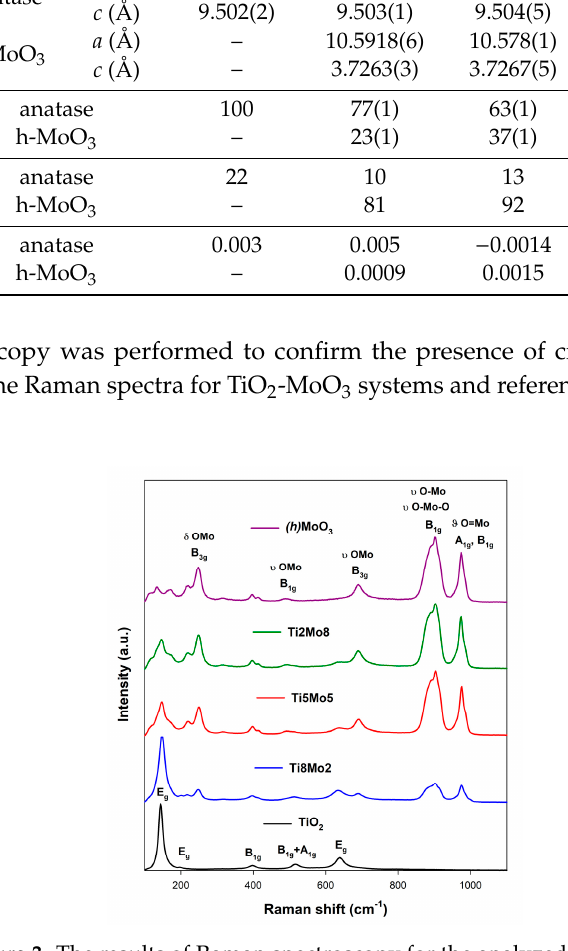
Figure 3. The results of Raman spectroscopy for the analyzed materials.